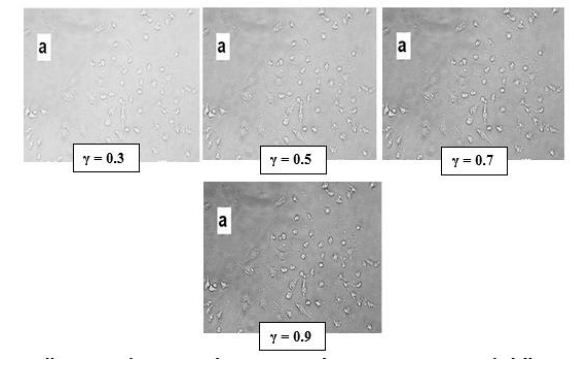
Figure 3. Illustrating the impact of Gamma transformation on images with different gamma values